Question: In a single sentence, describe what this figure presents.
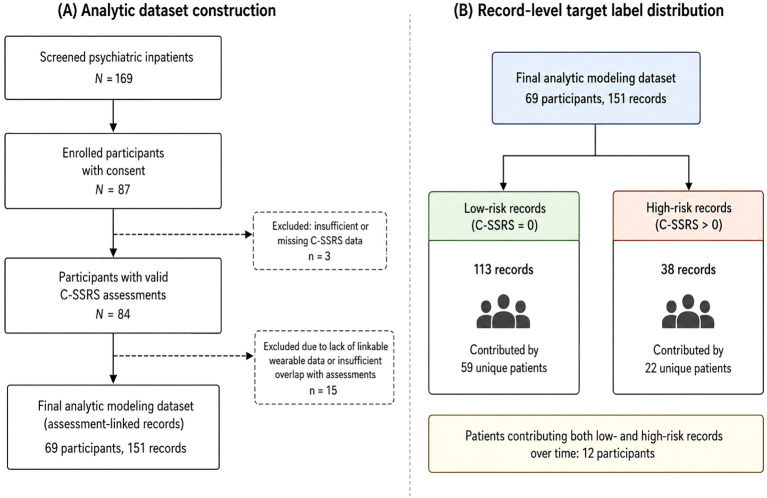
Answer: Participant enrollment and transition from patient-level cohorts to the record-level predictive modeling dataset. (A) Analytic dataset construction flow. Of 169 screened psychiatric inpatients, 87 participants were enrolled and included in the baseline demographic and clinical summary cohort. Among them, 84 participants had valid Columbia-Suicide Severity Rating Scale (C-SSRS) assessments. The final analytic modeling dataset was constructed from 69 participants with both valid C-SSRS labels and temporally aligned wearable-derived sleep/activity features, yielding 151 assessment-linked observation records. (B) Record-level target label distribution in the final analytic modeling dataset. Low-risk records were defined as C-SSRS = 0 and high-risk records as C-SSRS > 0; the dataset included 113 low-risk records and 38 high-risk records, contributed by 59 and 22 unique participants, respectively, with 12 participants contributing records to both classes over time.